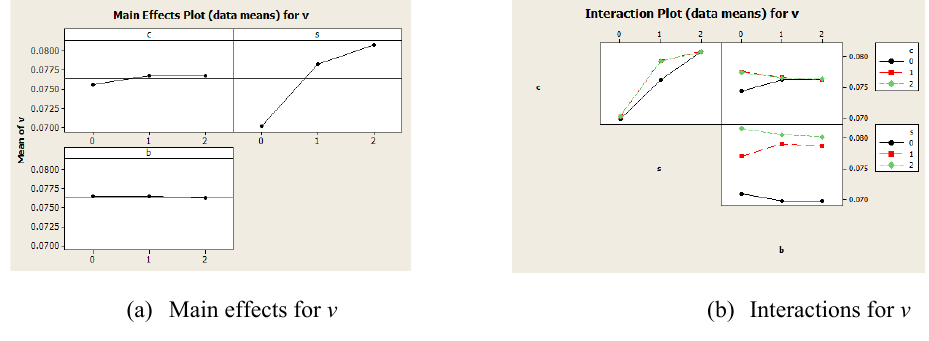
Fig. 2 Main effects and the interactions plot for the raw material sales price